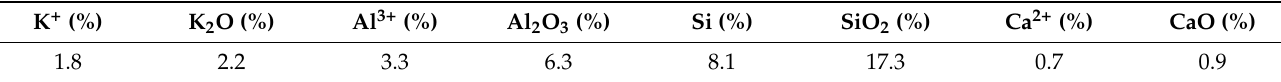
Table 2. Typical chemical composition of the clay used in this